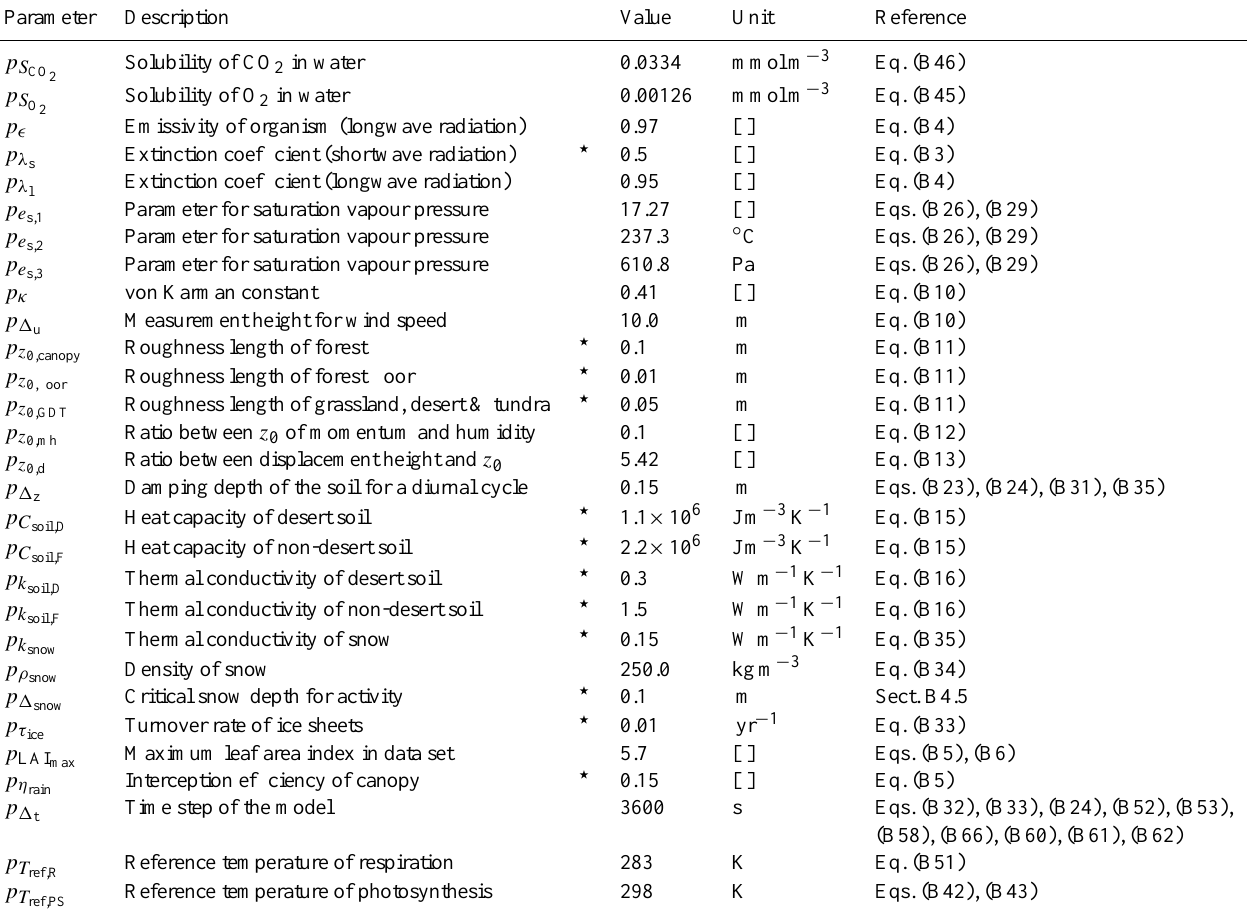
Table B8. Overview of model parameters describing environmental conditions. Parameters marked by the ? -symbol are included in a sensi- tivity analysis (see Table 2) because their values are not known very